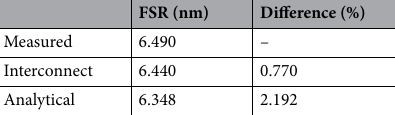
Table 2. Calculated FSR from measurements, Interconnects, and analytical model of the LT-aMZI with ΔL = 44.7 µm.